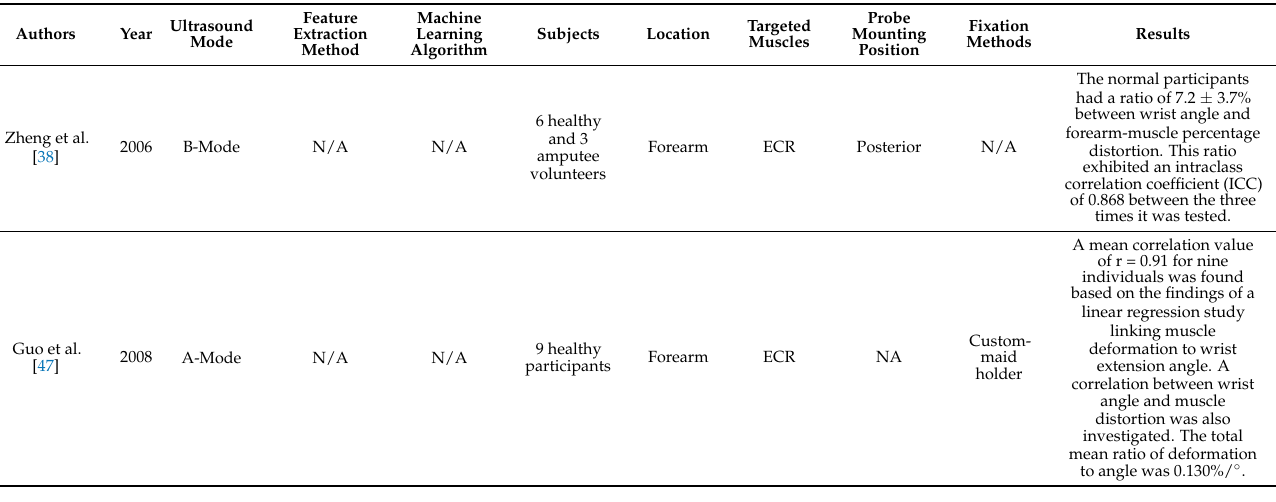
Table 1. Summary of the methods and results of the SMG controlling system used in the past 16